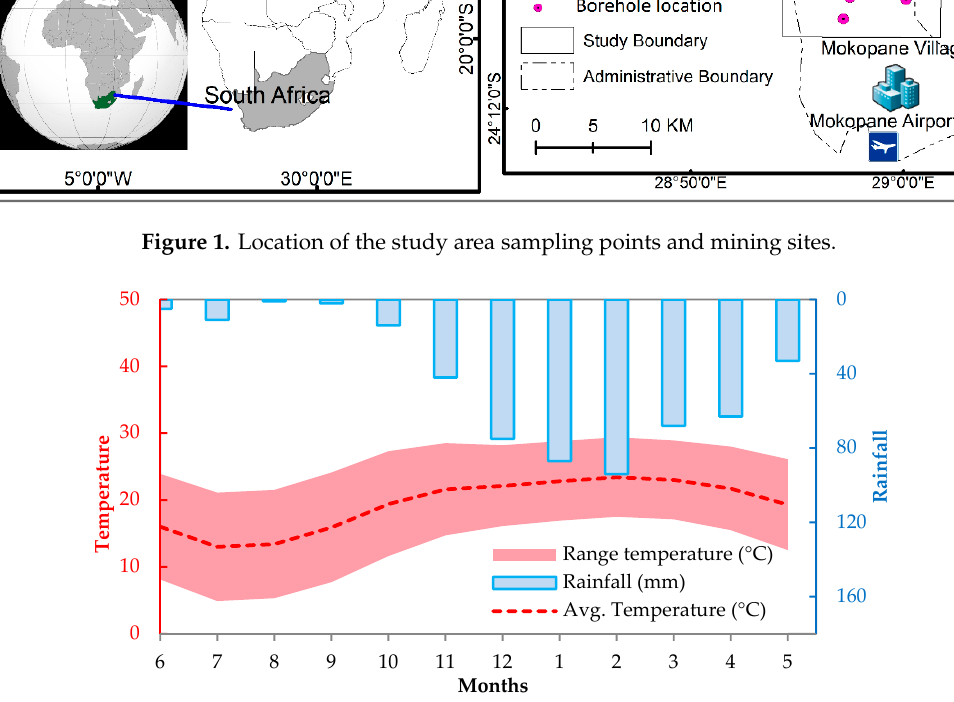
Figure 2. Climate data of average rainfall and temperature in Mokopane.